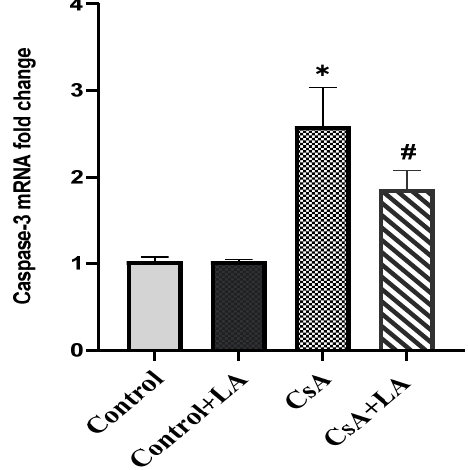
Figure 7. Effect of α -LA on caspase-3 mRNA fold change in hepatic tissues from various experimental groups. Data are expressed as mean ± SE. * the CsA-treated group versus the control group at p < 0.05. # α -LA + the CsA-treated group versus the CsA-treated group at p < 0.05.